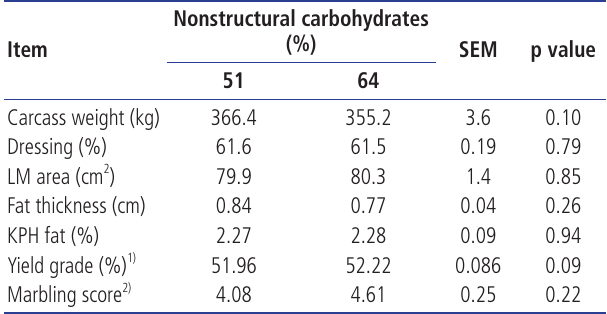
SEM, standard error of the mean; LM, longissimus muscle; KPH, kidney, pelvic